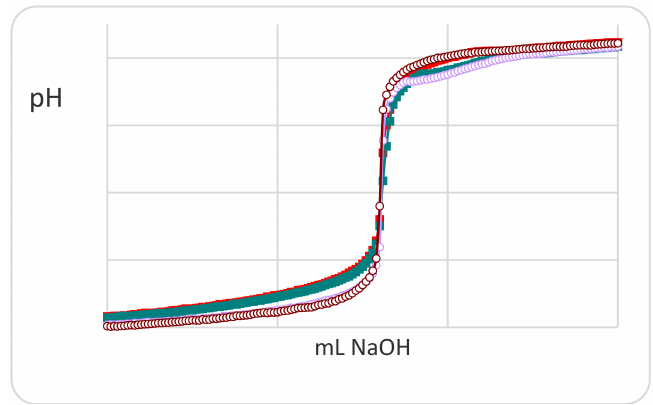
Figure 1. Potentiometric titration curves of monomer N -acryloyl- L -phenylalanine (PHE) in the absence (red filled) and in the presence (green filled) of Ag(I) ions. For comparison, the titration curves of nitric acid (brown open) and silver(I) ions (violet open) are also